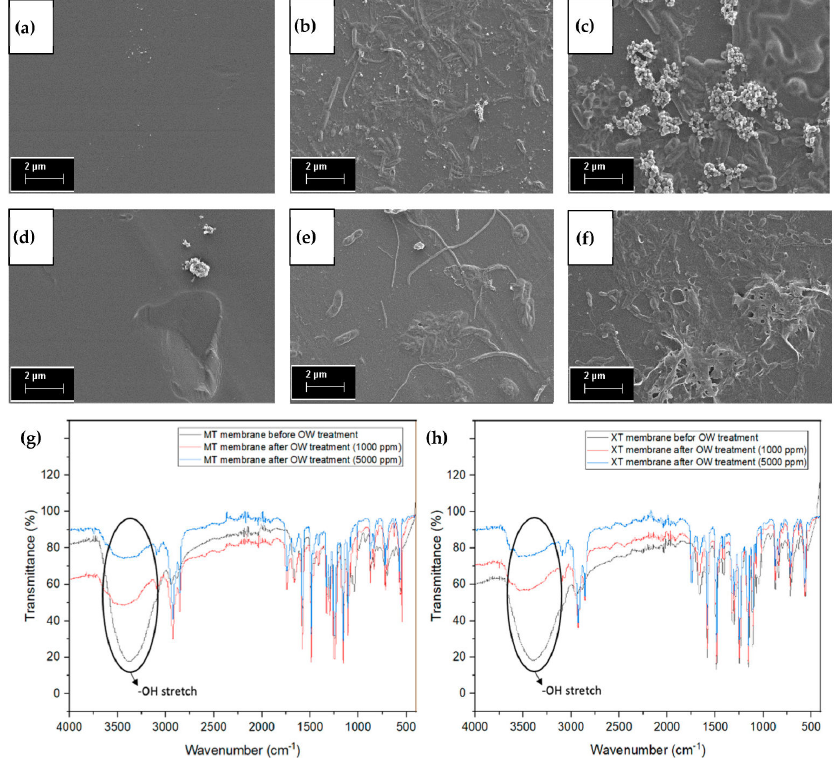
Figure 6. FESEM images of ( a – c ) MT and ( d – f ) XT membrane ( a , d ) before and after OW treatment, which takes place at the concentration of ( b , e ) 1000 and ( c , f ) 5000 ppm. FTIR spectra of ( g ) MT and ( h ) XT membrane before and after OW